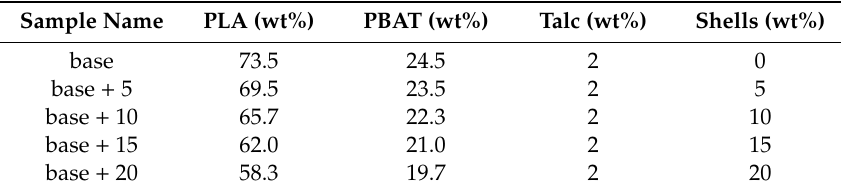
Table 1. Composition of the